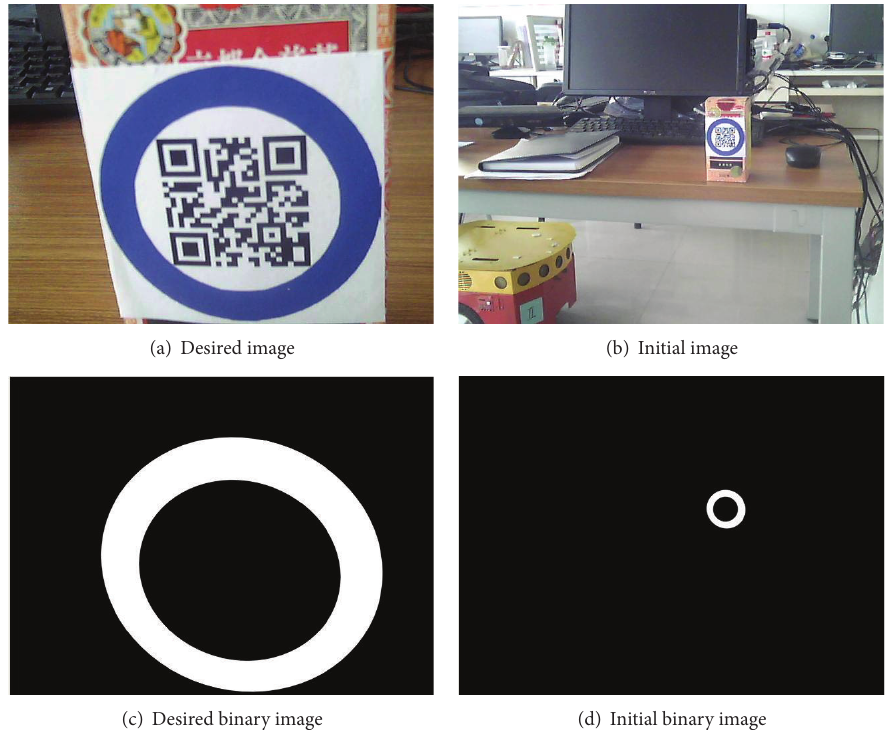
Figure 7: Images of the target for the desired/initial camera position and object mark recognition using Gaussian model and Hough transformation.